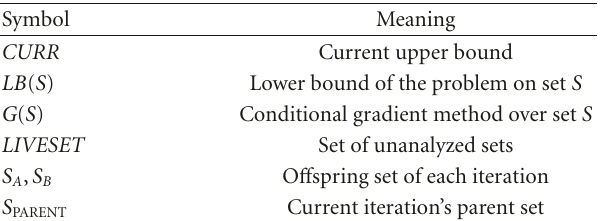
Table 2: Branch and bound method notation summary. Symbol Meaning Current upper bound Lower bound of the problem on set S Conditional gradient method over set S Set of unanalyzed